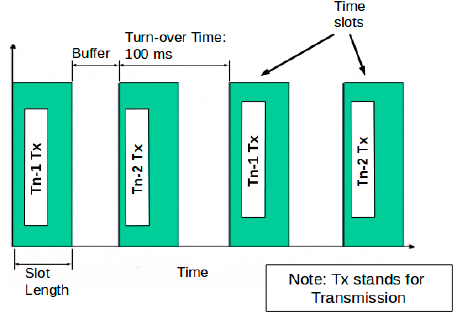
Figure 5. Time division multiplexing (TDM) working principle.